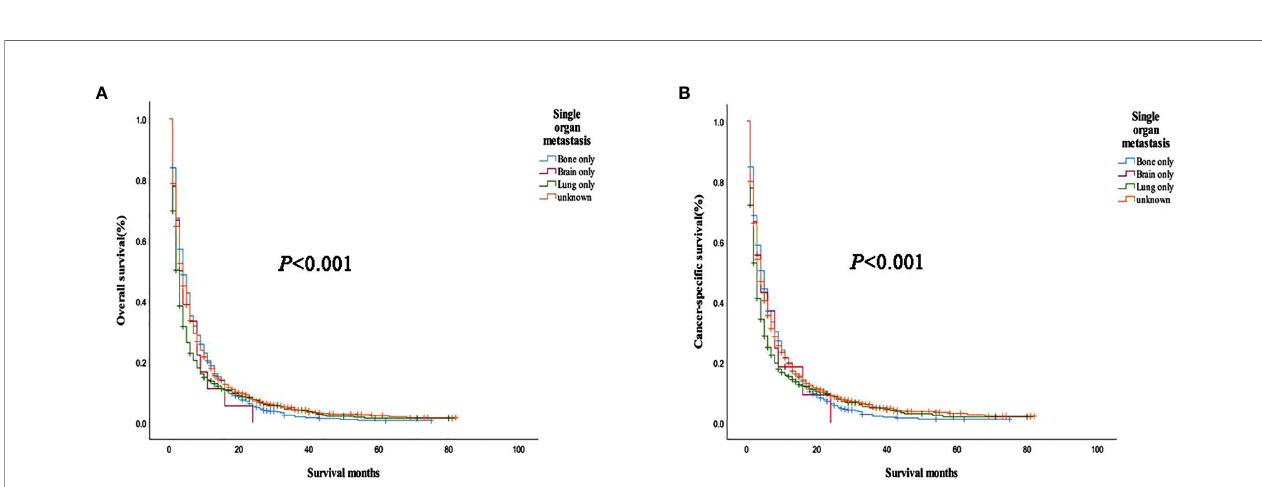
FIGURE 3 | (A) Overall survival and (B) Cancer-speci fi c survival curves of patients with different metastatic